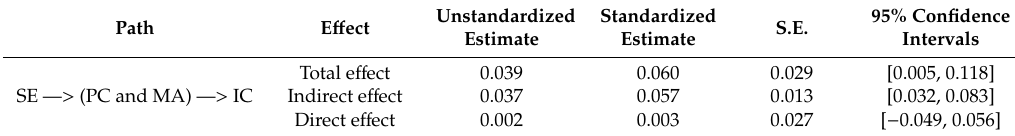
Table 6. The results of mediating effect. (N = 1548).